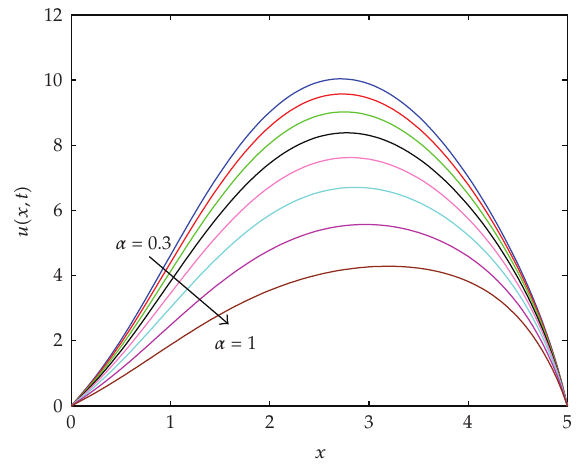
Figure 9: Numerical solutions for Example 5.4 with fixed μ (cid:7) 1 . 8 at time T (cid:7) 1 . 0, and di ff erent values of α (cid:7) 0 . 3 , 0 . 4 , 0 . 5 , 0 . 6 , 0 . 7 , 0 . 8 , 0 . 9 , 1 .